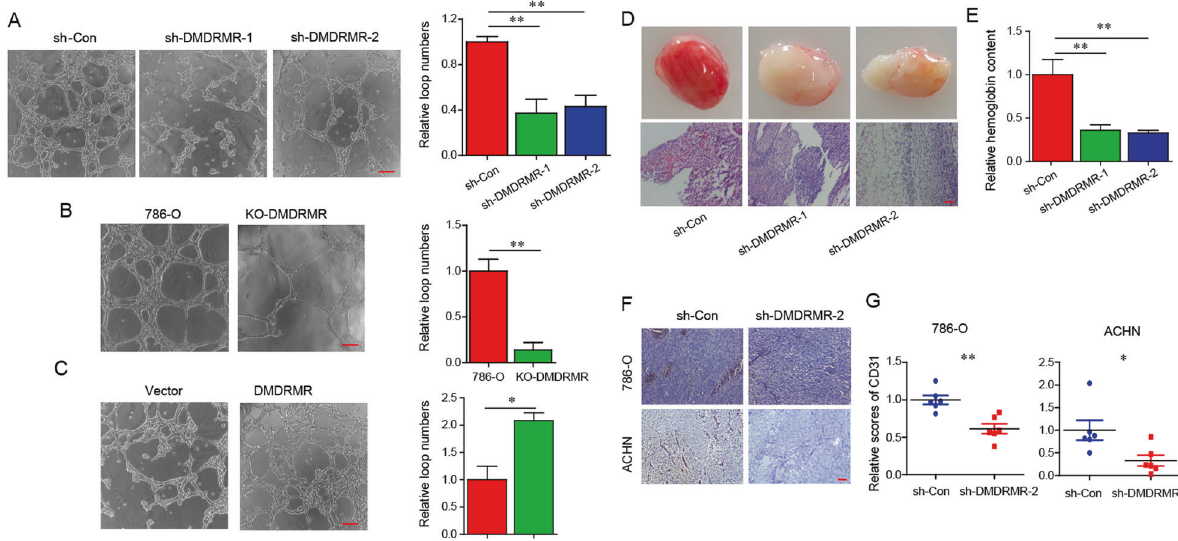
Fig. 2 DMDRMR drives tumor angiogenesis. A – C Representative bright- fi eld images (left) and quanti fi cation (right) of matrigel tube formation of HUVECs incubated with conditioned medium from DMDRMR KD ( A ) and KO ( B ) 786-O cells and OE 769-P ( C ) cells (scale bars, 200 µm). D Representative images (top) and H&E staining (bottom) of subcutaneous matrigel plug assay in DMDRMR KD mice (scale bars, 200 µm). E Relative hemoglobin contents were measured from the experiment ( n = 6). F , G Representative bright- fi eld images ( F ) and quanti fi cation ( G ) of CD31 IHC staining from tumor tissues of NSG mice injected with DMDRMR KD 786-O and ACHN cells (scale bars, 200 µm; n = 6). The results are presented as mean ± SEM. * p < 0.05, ** p < 0.01, *** p <